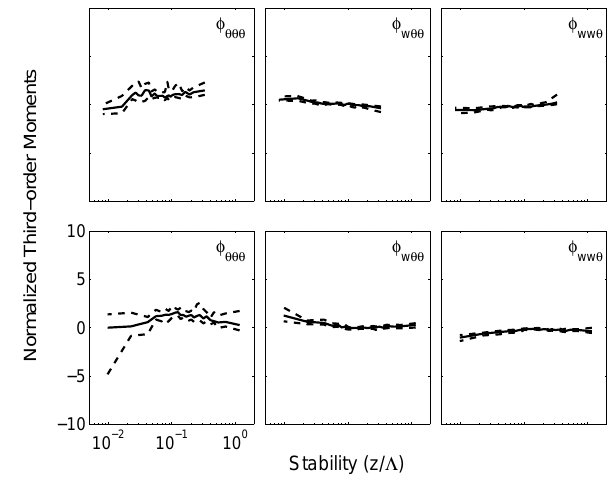
3 i h θ 0 c , θ 3 ∗ L